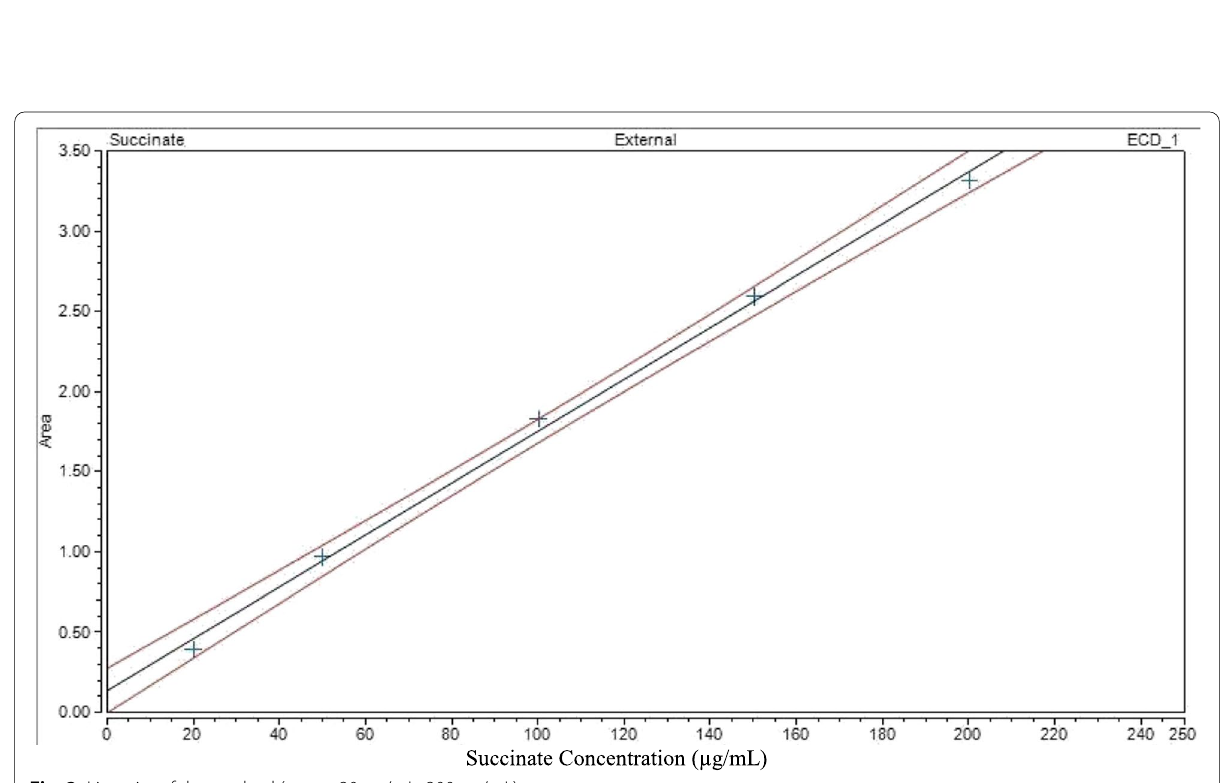
Fig. 2 Linearity of the method (range: 20 μg/mL–200